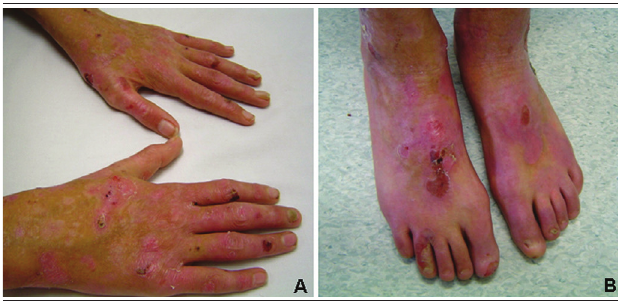
figurE 1 − Images of the patient’s hands and feet showing blistering and scarring skin lesions, in addition to dystrophic and missing nails (especially in the feet), secondary to EB EB: epidermolysis